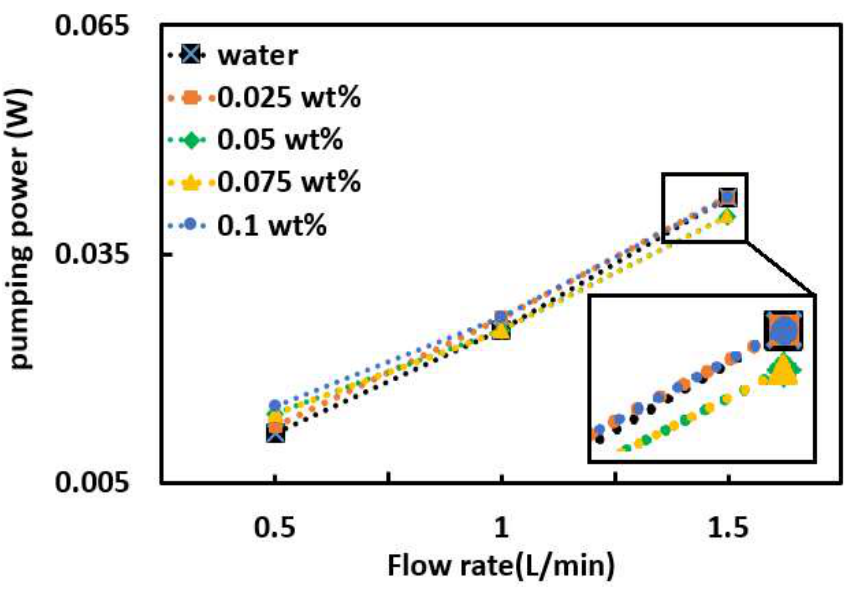
Figure 7. Effect of volumetric flow rate on pumping power and pressure drop at varying particle concentration.